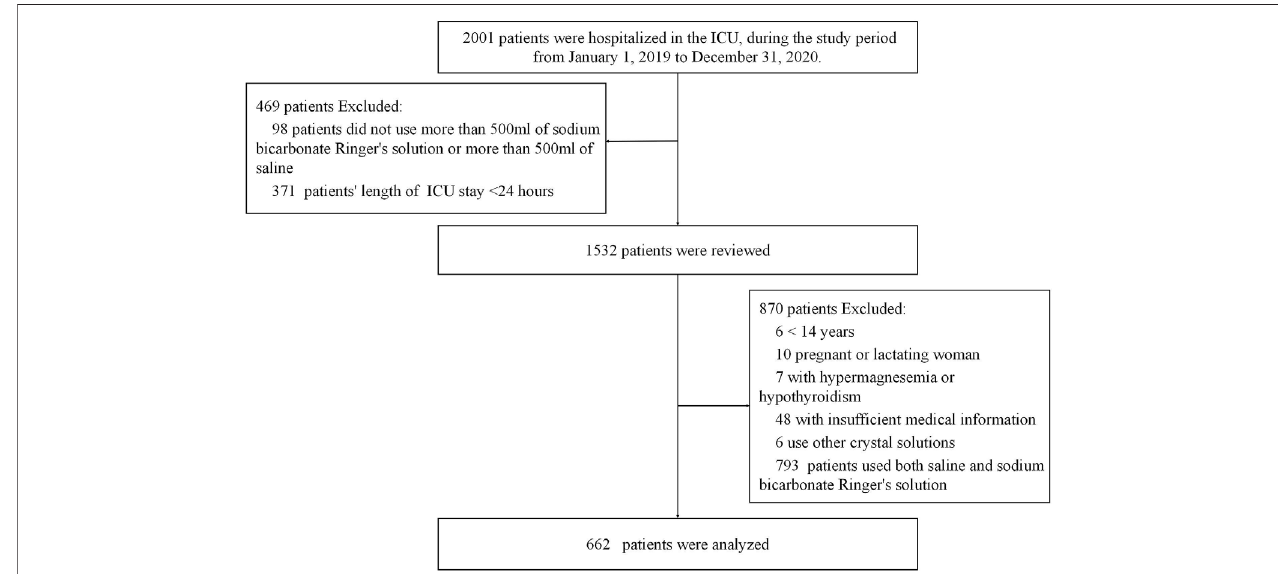
FIGURE 1 | Flowchart. Abbreviations: ICU, intensive care